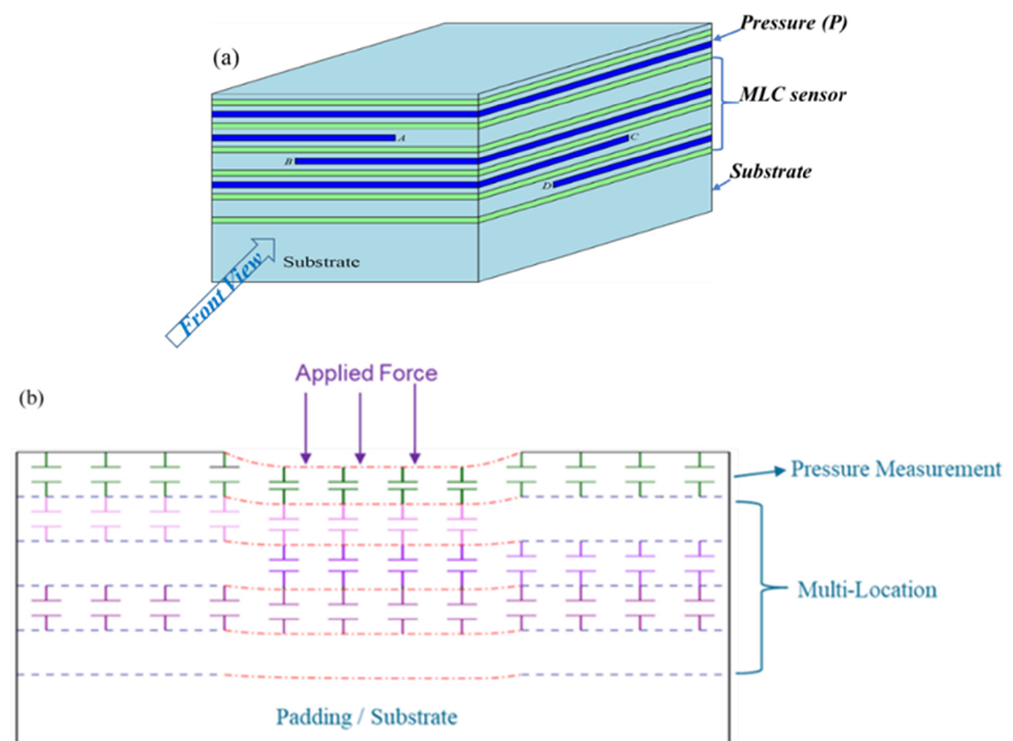
Figure 6. Multimodal capacitive DE sensor consisting of a pressure sensor, P (on the top of the sensor), MLC sensor (in the middle), and substrate/padding (bottom). Each sensor contains electrodes that are separated by a dielectric layer. ( a ) A cross-section of the sensor showing the different layers, ( b ) the change in capacitance in the different layer as viewed from the front.